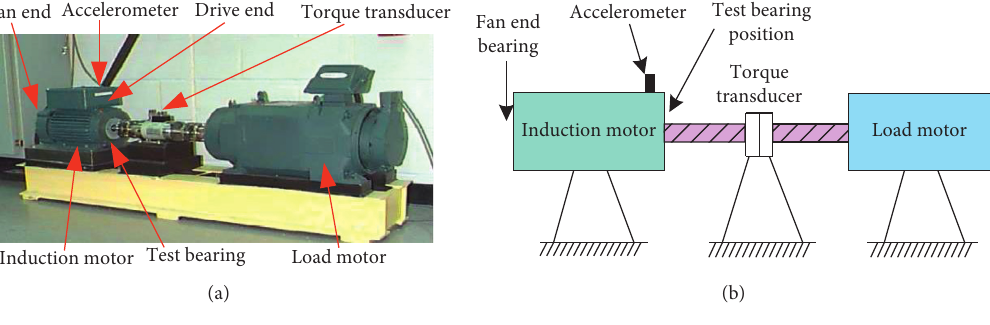
Figure 14: The experimental device and its